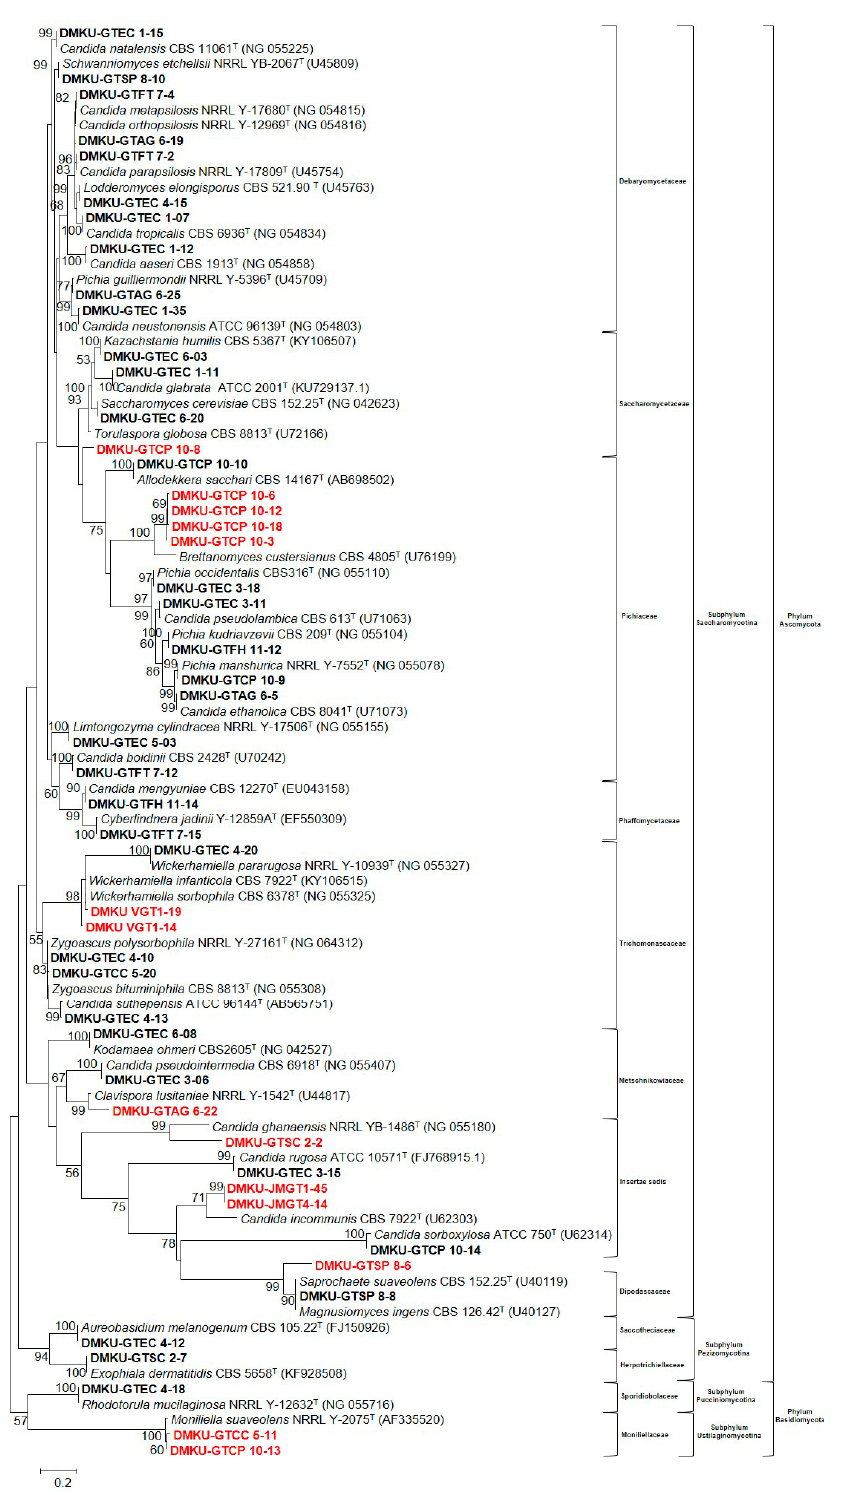
Figure 2. Phylogenetic relationships among the sequences of the D1 / D2 domain of the large subunit (LSU) rRNA gene of representative yeast species from grease traps in the phylum Ascomycota, the phylum Basidiomycota, and their closely related yeast sequences retrieved from the GenBank database, as calculated using maximum likelihood method (GTR model). Undescribed species are presented in red color and the isolated yeast are presented in bold letters. Numbers on branches represent the bootstrap percentage ( > 50%) from 1000 random